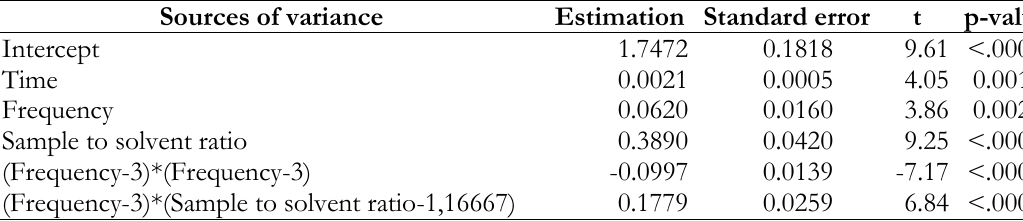
Table II. Estimation of coefficient regression